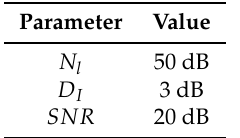
Table 2. Physical layer